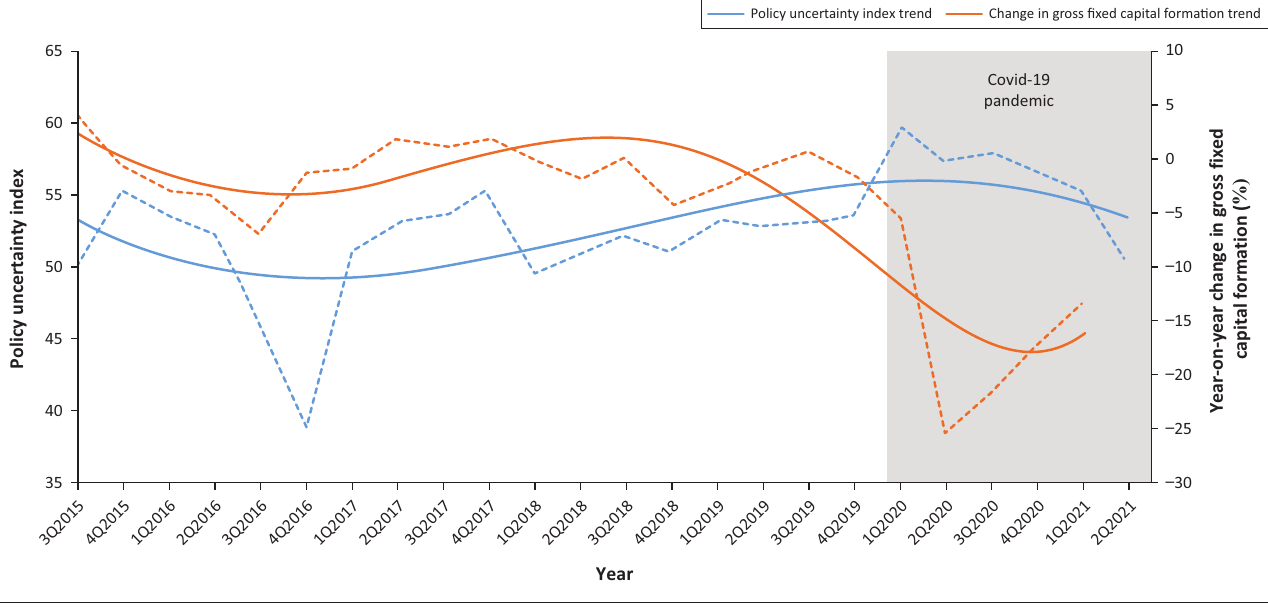
FIGURE 2: Policy uncertainty and